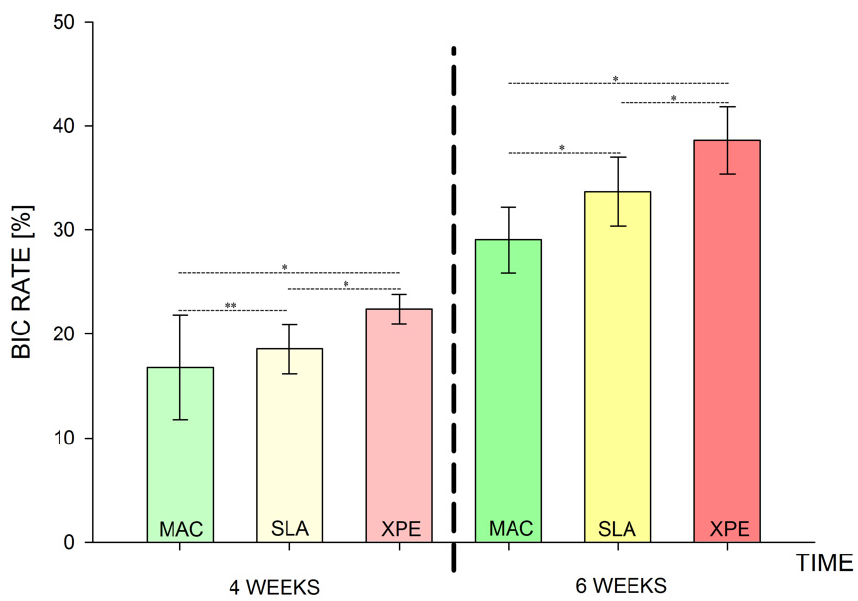
Figure 7. Graph reporting the BIC rate weighted for time. (* statistically significant ( p < 0.05); ** not statistically significant ( p > 0.05).